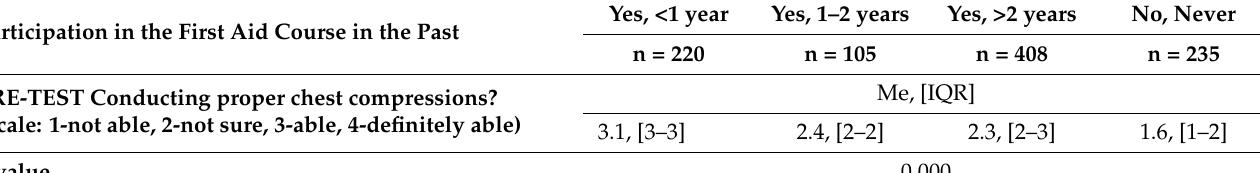
Table 2. Self-confidence scores for the ability to perform proper chest compressions depending on previous training.